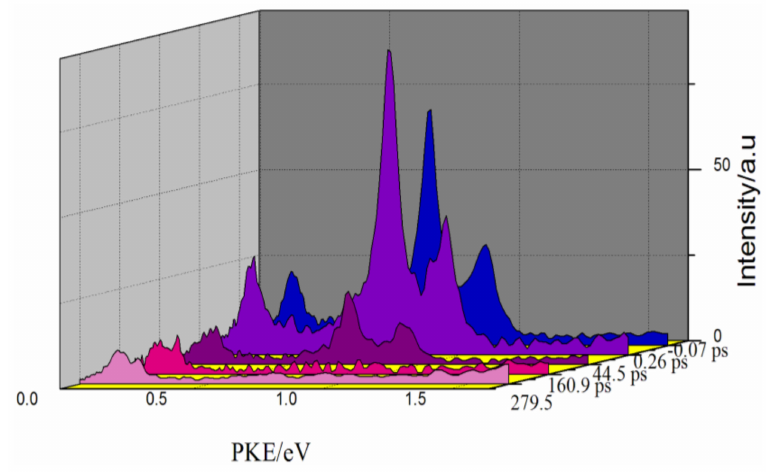
Figure 3. Photoelectron kinetic energy distributions (PKEs) at various time delays.